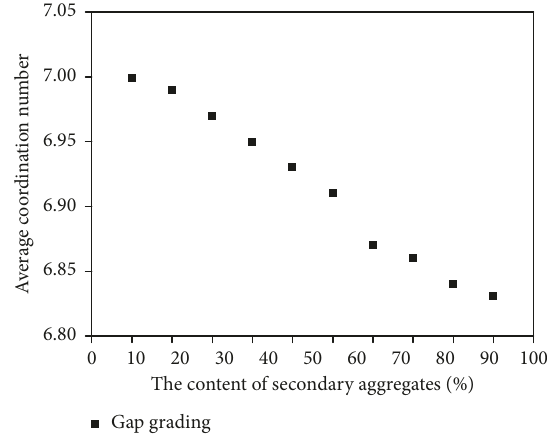
Figure 18: Variation of the average coordination number with the content of secondary aggregates.